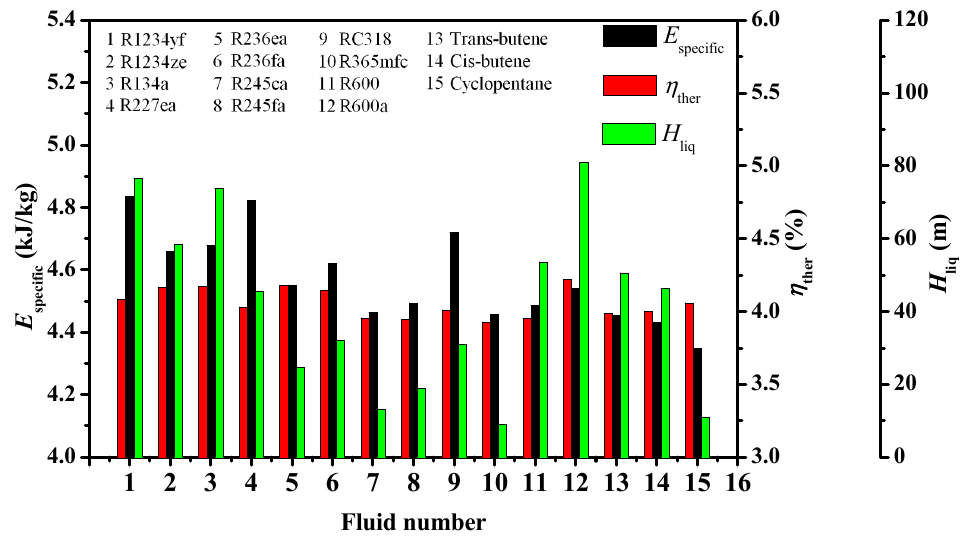
Figure 11. Performance comparison in each optimal condition.